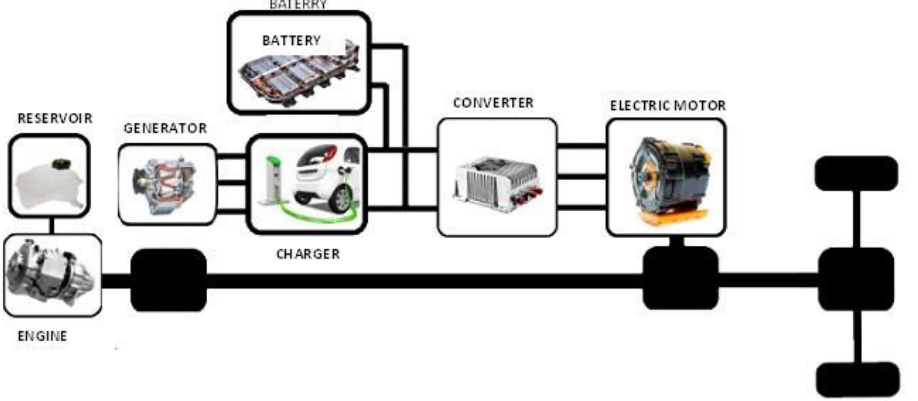
Figure 3. Structure of a plug-in hybrid electric vehicle.